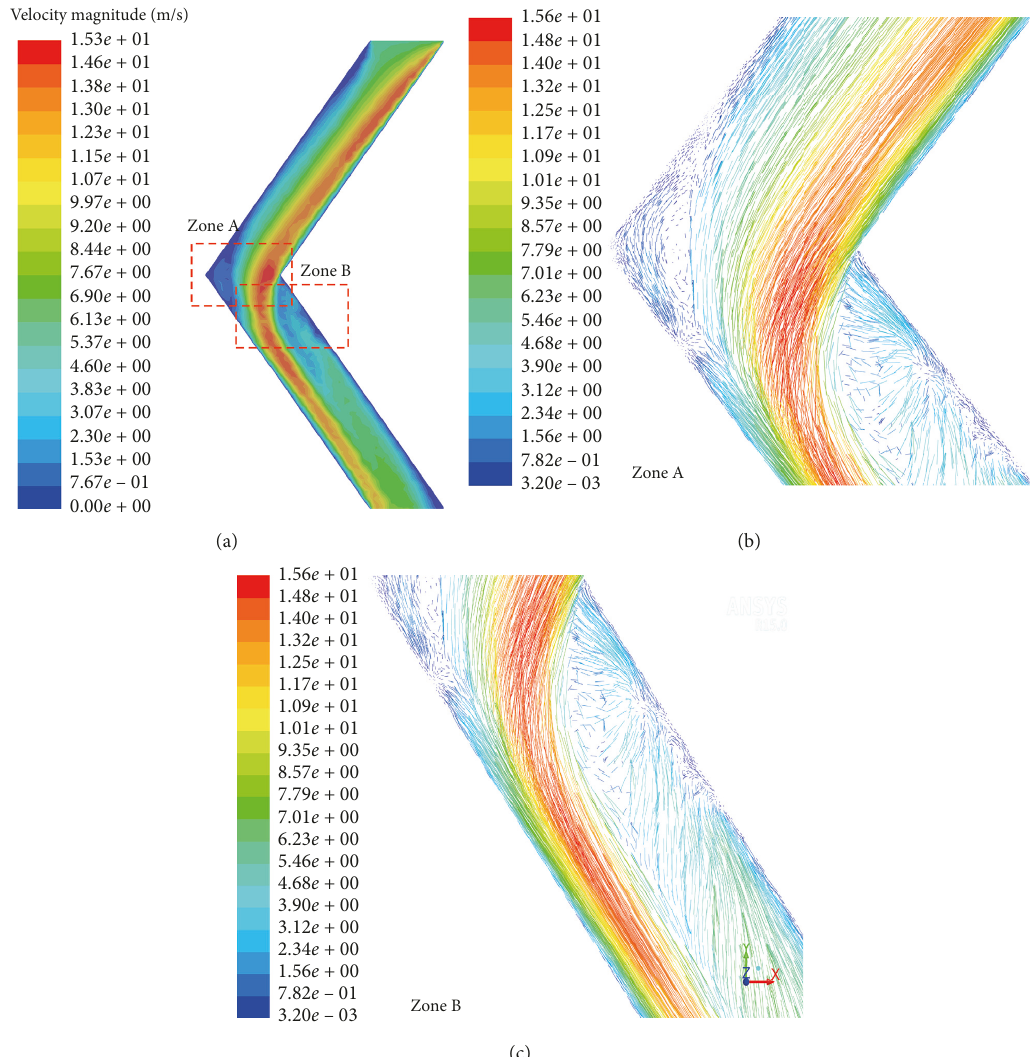
Figure 4: Airflow field in the impactor. (a) Velocity magnitude contour of the impactor; (b) velocity vectors of the recirculation zone A; (c) velocity vector of the recirculation zone